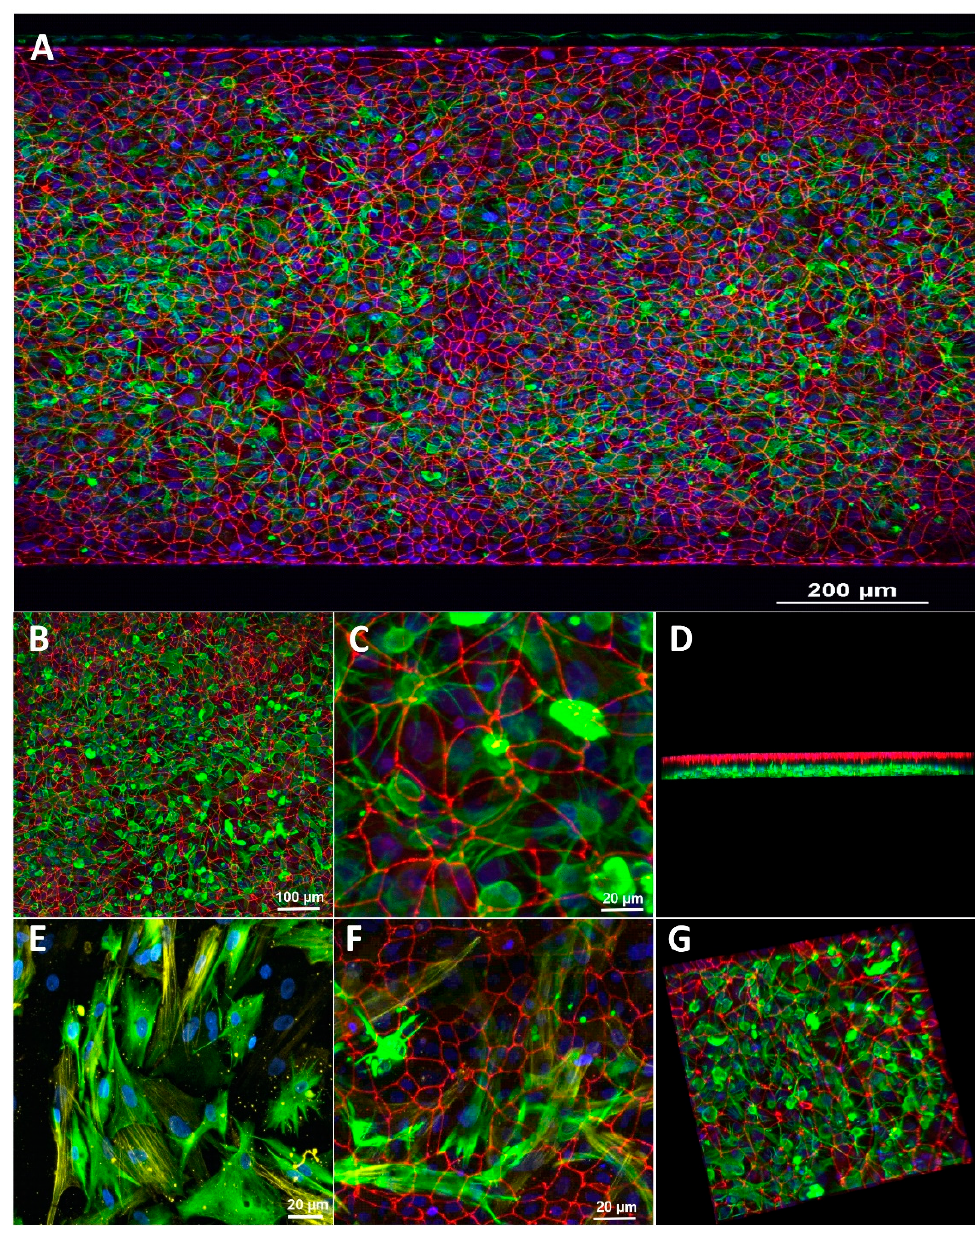
Figure 2. Immunofluorescence images demonstrating the co-culture and triculture of the BBB on a chip. iBMECs cultured on all surfaces of the blood channel, and primary human brain pericytes and astrocytes on the apical brain channel. ( A – C ) Different magnifications of iBMECs stained with ZO-1 (red); iBMECs form a tight barrier on the blood side; astrocytes were stained with GFAP (green). ( D , G ) 3D structure of the co-culture. ( E ) Co-culture staining of primary human astrocytes (GFAP, green) and primary human pericytes ( α -SMA, yellow) in the brain channel. ( F ) Triculture staining of the BBB on a chip (red, iBMECs-ZO-1; green, astrocytes (GFAP); yellow, pericytes ( α -SMA)).